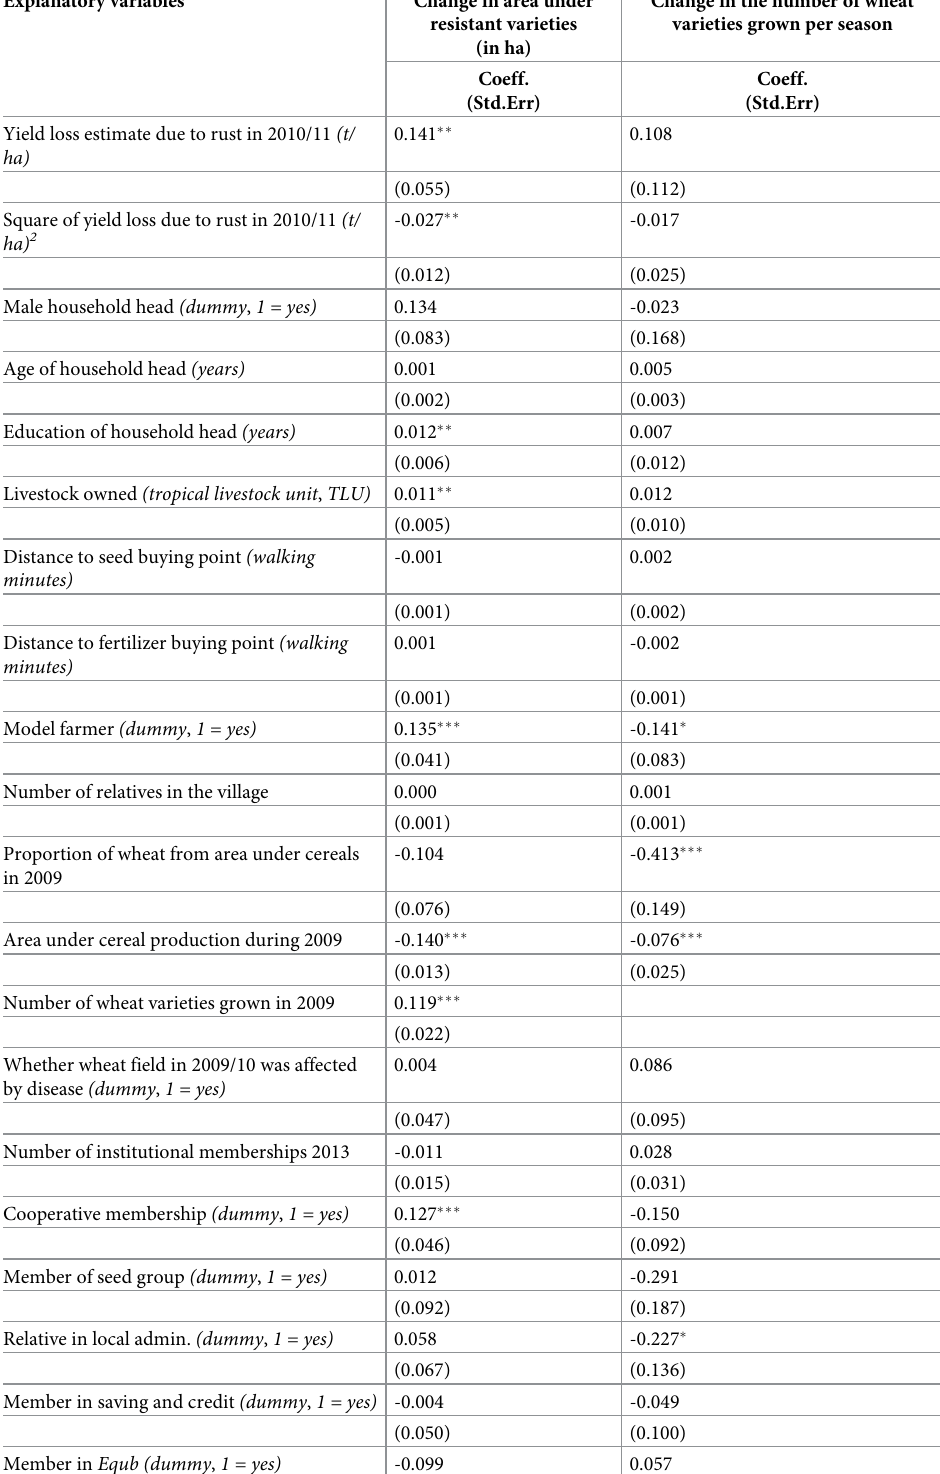
Table 8. Explaining variations in changes made to wheat area under resistant varieties and number of varieties grown as a coping strategy (between 2009/10 and 2013/14